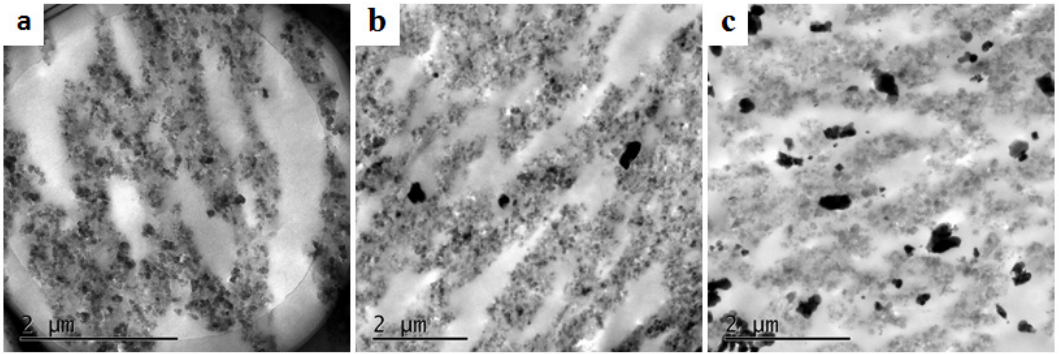
Figure 7. Transmission electron microscopy (TEM) micrographs of the semiconductive materials with different LSC contents: ( a ) 0 wt% LSC; ( b ) 0.5 wt% LSC; ( c ) 3 wt% LSC.